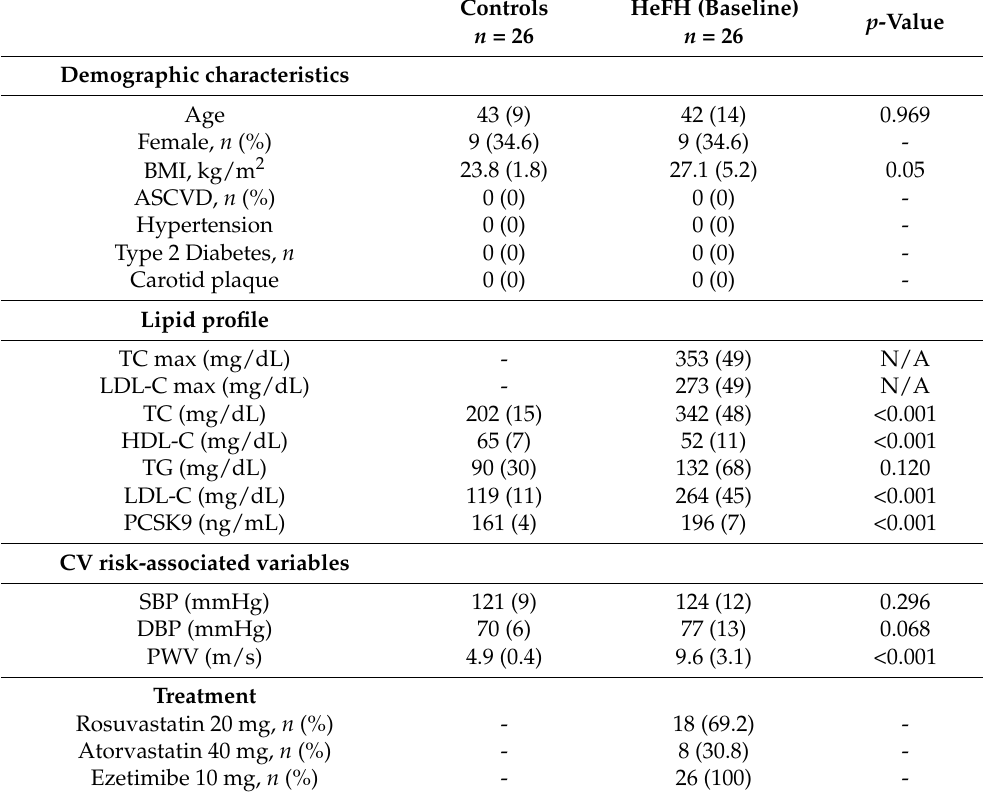
Table 1. Baseline characteristics of participants and controls.